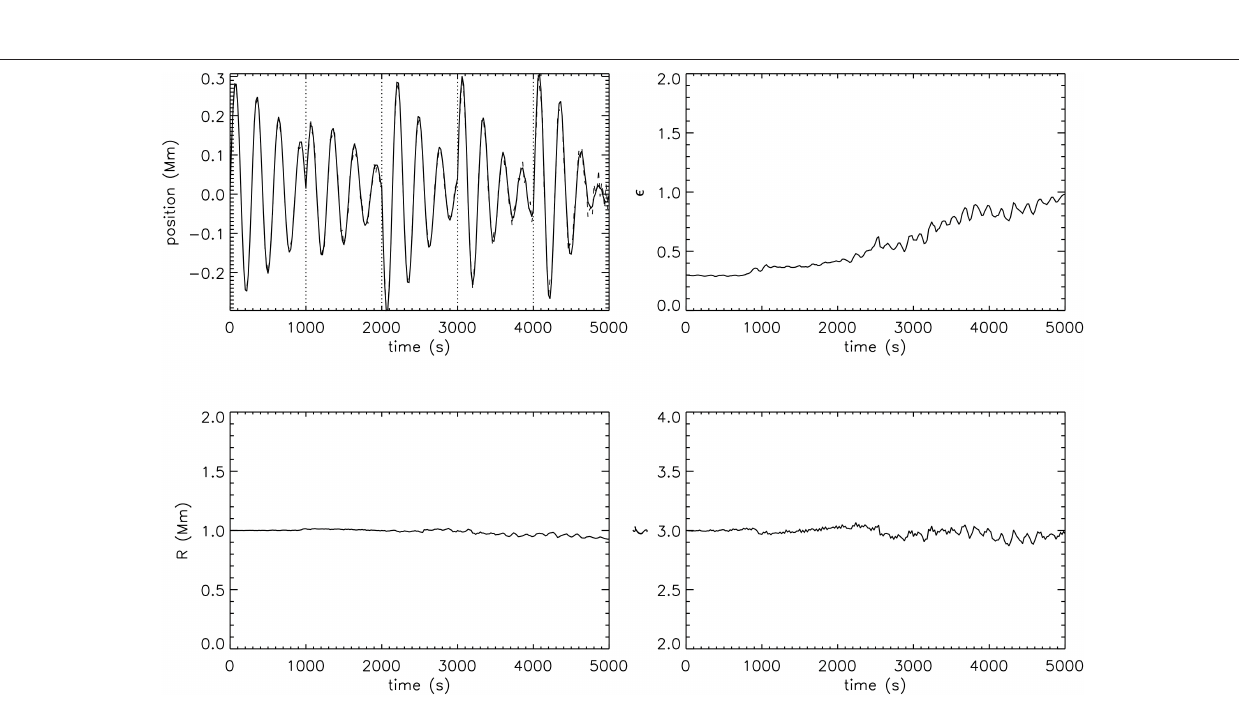
Frontiers in Astronomy and Space Sciences | www.frontiersin.org